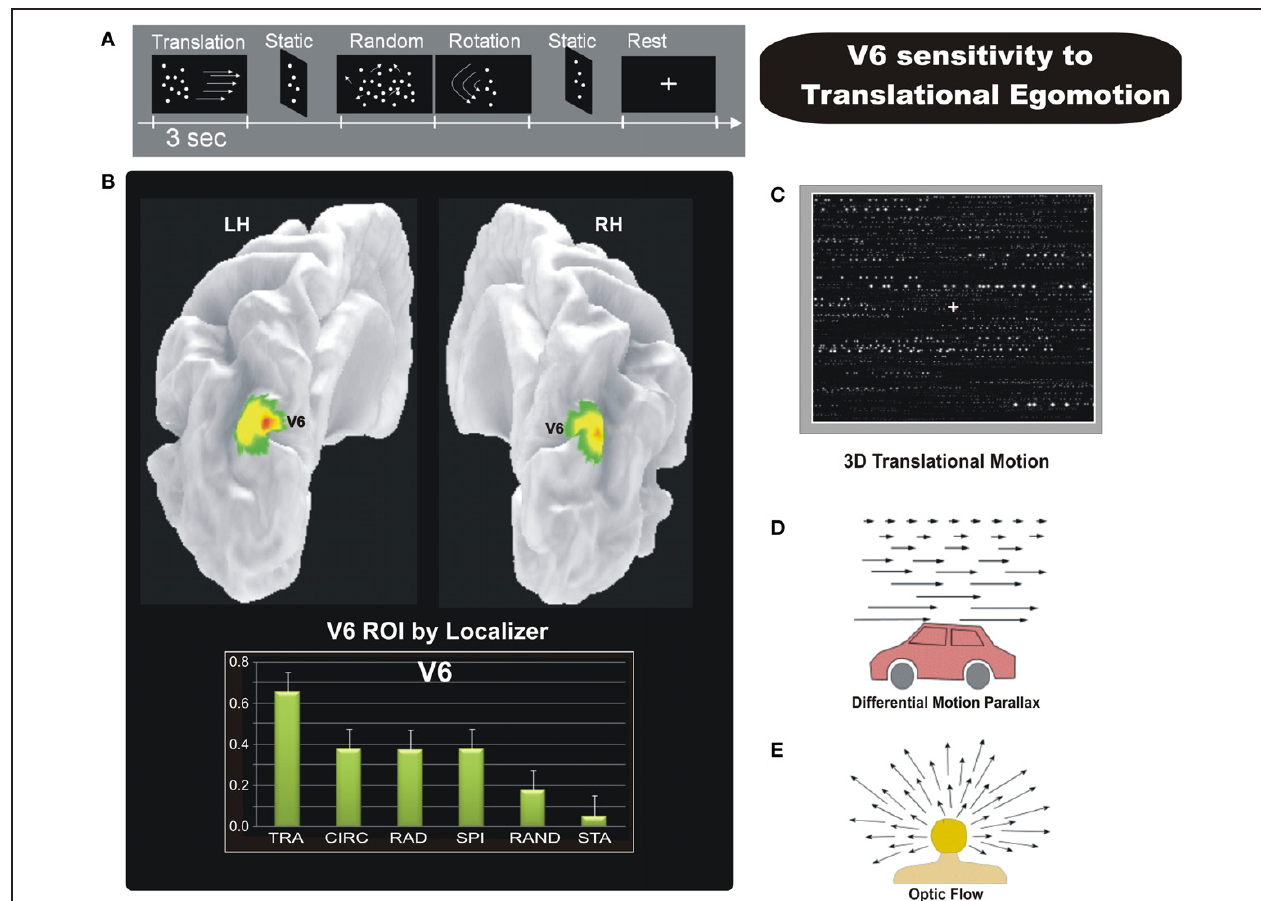
FIGURE 7 | Sensitivity of human V6 to Translational egomotion. (A) Schematic representation of the visual stimulation sequence used in the event-related fMRI experiment. (B) Top: Area V6 mapped with the functional localizer, i.e., coherent flow vs. randomly moving dots (shown in Figure 6A ). Results are displayed on a posterior dorso-medial view of the medial folded representation of the left and right hemisphere of the template brain. Bottom : The plots represent the averaged BOLD percent signal change across subjects and hemispheres in the localizer-defined area V6 for each experimental condition labelled as follows: TRA, translational; CIR, circular; RAD, radial; SPI, spiral; RAND, random; STA, static. (C) Sketch of the tridimensional translation stimulus used in the fMRI experiment. [ A–C Modified from Sdoia et al. (2009)]. (D) Differential motion parallax. Differential motion parallax is the perceived difference in